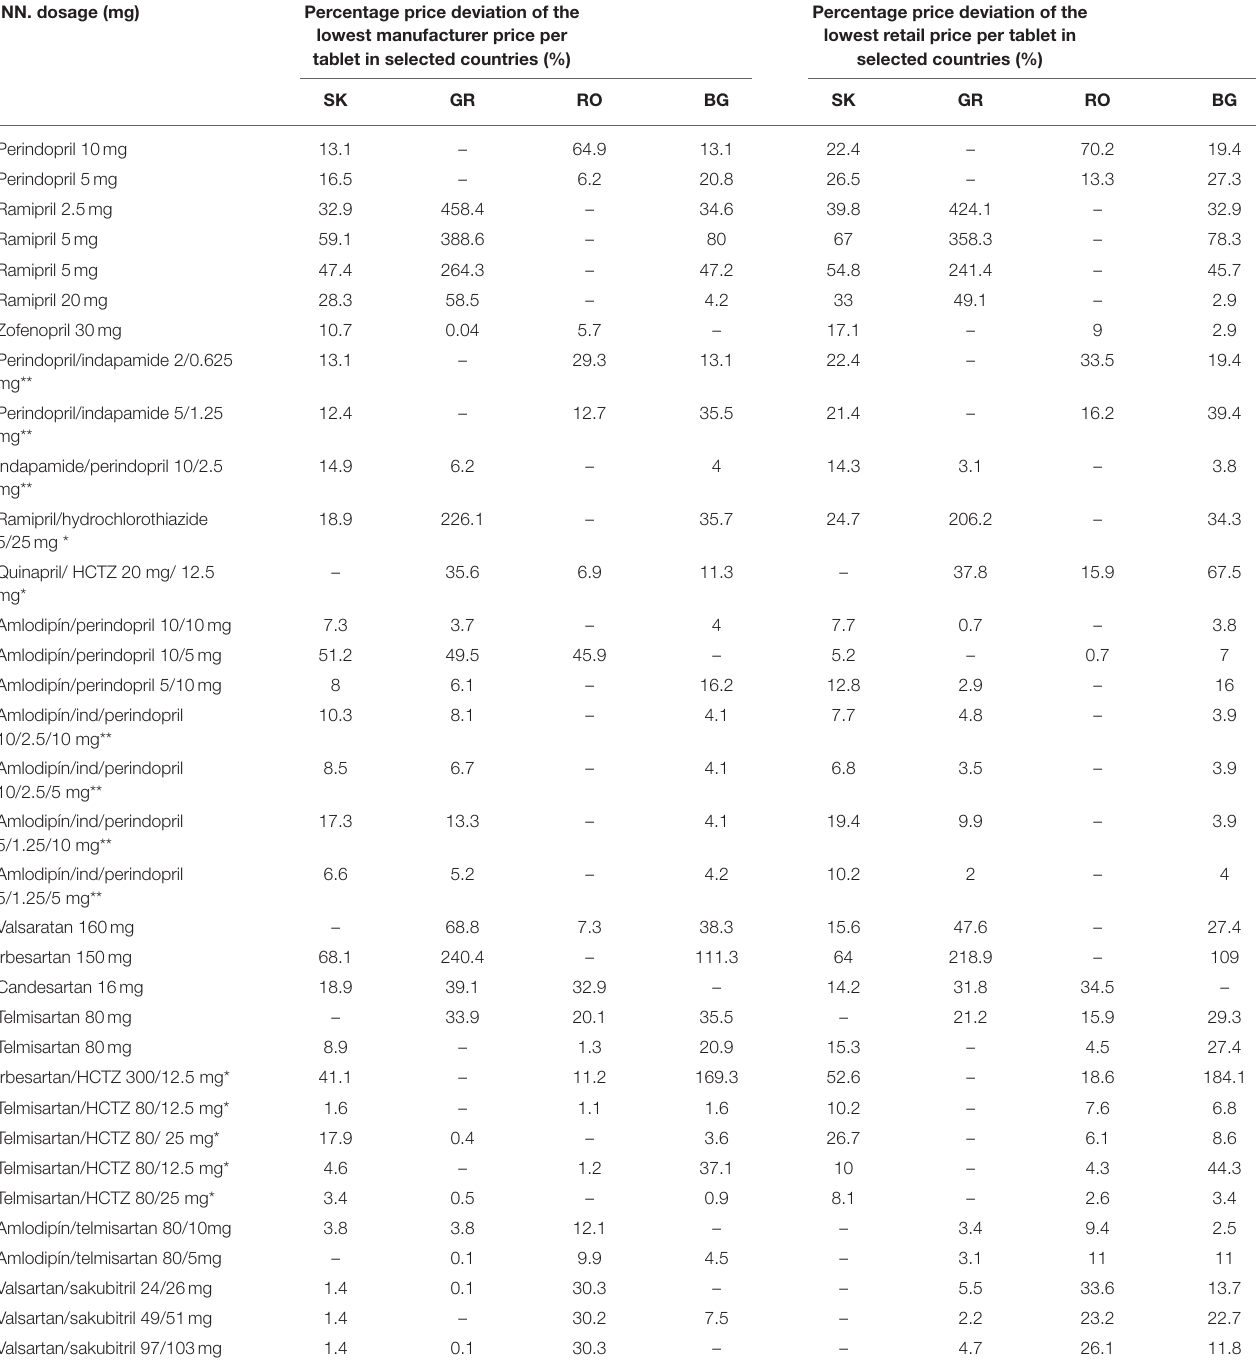
TABLE 4 | Percentage of deviation from the lowest manufacturer and retail price (%). INN. dosage